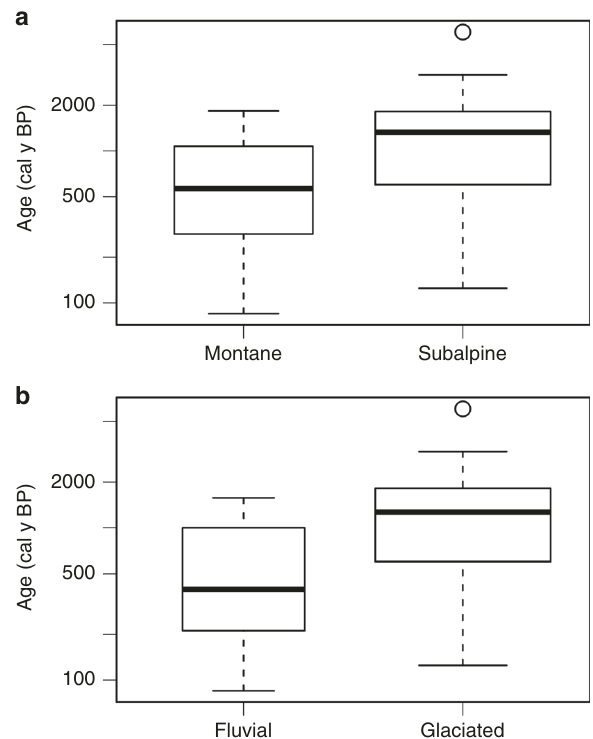
Fig. 7 Boxplots for mean age from adjusted t tests. All 52 calibrated ages between all study sites are included to examine differences in the montane and subalpine zones ( a ) and those upstream (glaciated) and downstream ( fl uvial) of the Pleistocene terminal moraine ( b ). P values are 0.003 and 0.0007, respectively. Thick lines represent the median (50th percentile), upper, and lower edges of the boxes represent the 25th and 75th percentile. Whiskers extend to the minimum and maximum values within 1.5 times the interquartile range and open circles are outliers exceeding that